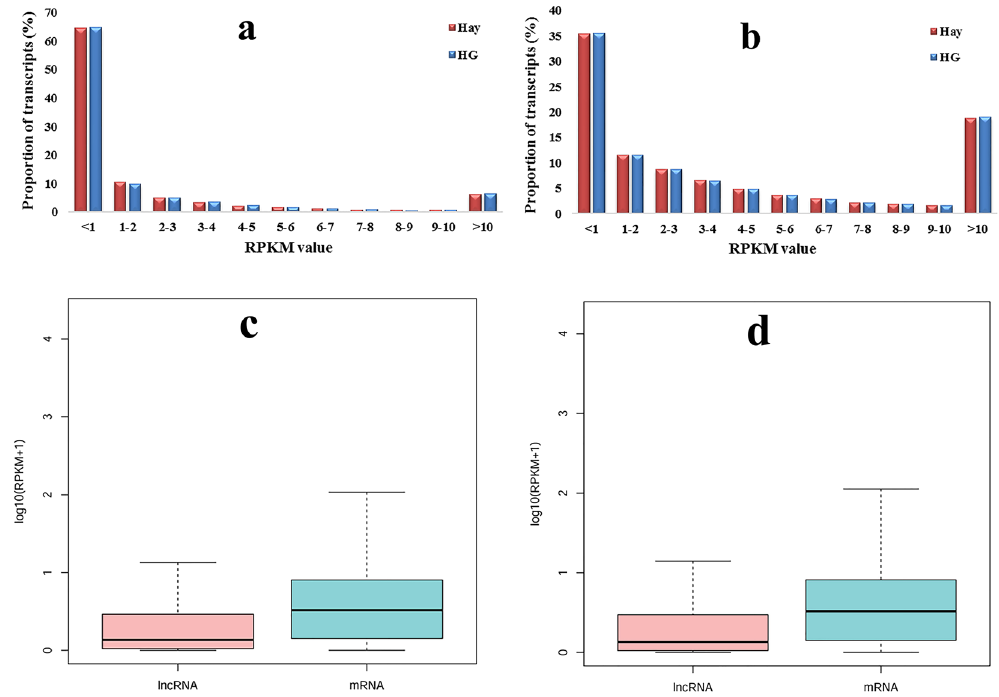
Figure 5. RPKM value of lncRNAs and mRNAs in sheep testis tissues. ( a and b ) represent the RPKM value of all the identified lncRNAs and mRNAs in the two groups, respectively. The boxplots in ( c and d ) show the expression levels of lncRNAs and mRNAs in the testis tissues of sheep in the hay and HG groups,